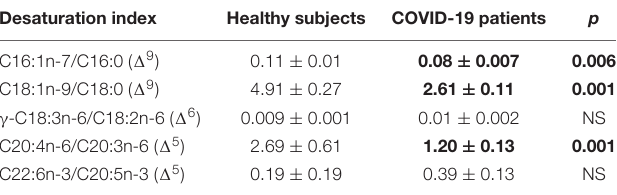
TABLE 8 | Indirect desaturation indexes of the desaturases in the fatty acids of the phospholipids from healthy subjects and COVID-19 patients.